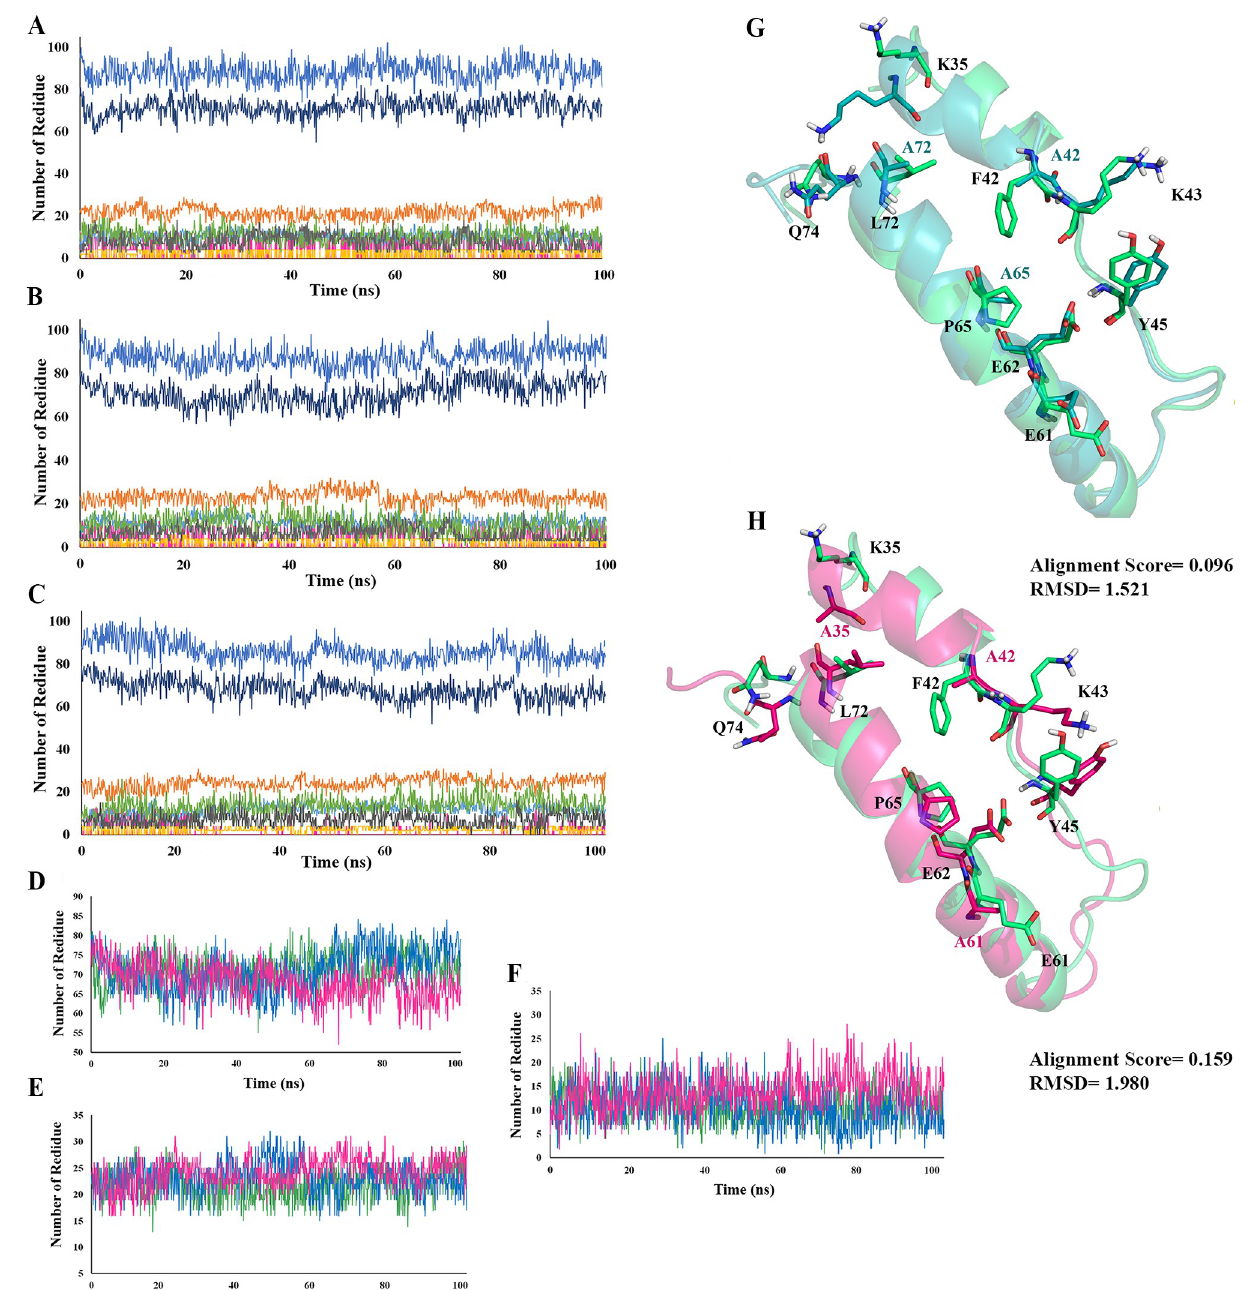
Fig 2. Secondary structure analysis. A. The native protein, B. Mutant 1 and, C. Mutant 2, during 100 ns of MDs (where the structure is shown in blue, α -helix in dark blue, 3-helix in gray, coil in orange, turn in green, β -sheet in magenta, b-bridge in yellow, and bend in cyan), D. α -helix structure of native structure (green), mutant 1(blue) and mutant 2 (magenta), E. Coil structure of native structure (green), mutant 1(blue) and mutant 2 (magenta), F. Turn structure of native structure (green), mutant 1(blue) and mutant 2 (magenta), G. superimposition of the native IL-2 and IL-2R α interacting residues over mutant 1, and H. superimposition of mutant 2 and IL-2R α interacting residues over mutant 2